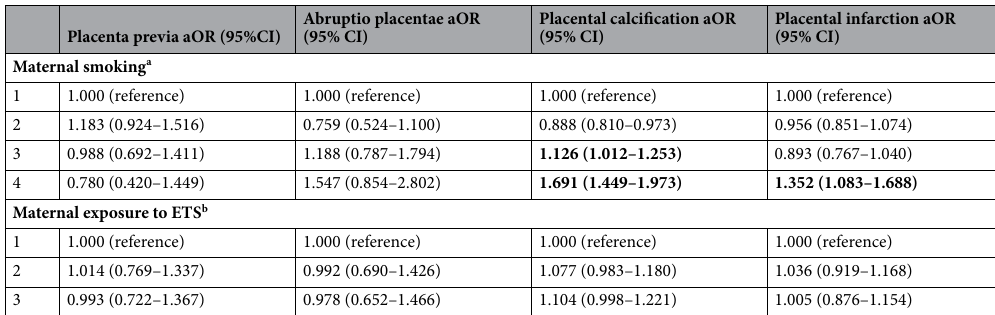
Table 3. Adjusted binominal logistic regression analysis of parental smoking for predicting placental abnormalities. Binominal logistic regression analysis was constructed to evaluate parental smoking for predicting placenta previa, abruption placentae, placental calcification, and placental infarction. The values are shown as adjusted odds ratios [aOR] (a 95% confidence interval [95% CI]). Bold, increasing or decreasing tendency of offspring’s smaller head circumference risk. a 1 = never smoked, 2 = quit before pregnancy, 3 = quit during pregnancy, and 4 = smoking during pregnancy. b 1 = seldom, 2 = 1–3 times a week, 3 = 4–7 times a week. Adjusted for maternal age, pre-pregnancy BMI and parity, maternal drinking during first to third trimesters, placental weight ratio, and gestational age.